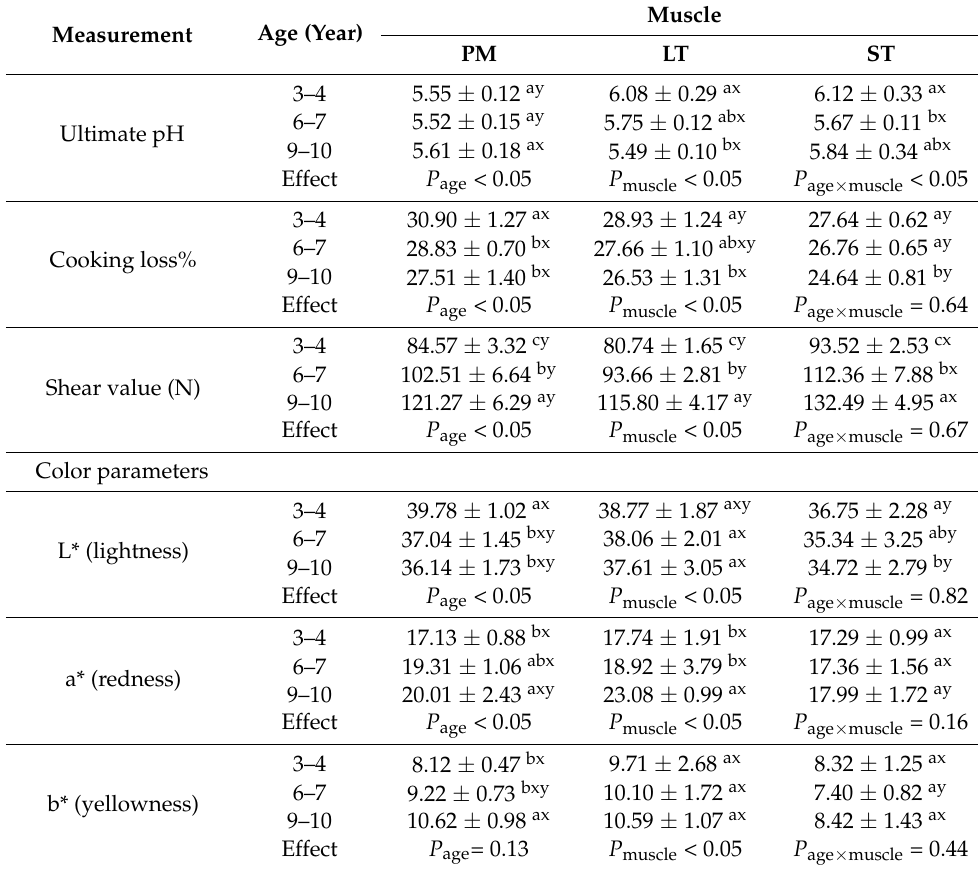
Table 5. Means and standard errors for meat quality characteristics of the Psoas major (PM), Longissimus thoracic (LT), and semitendinosus (ST) muscle samples from Alxa Bactrian camels ( n = 5, mean ± standard error) slaughtered at three different